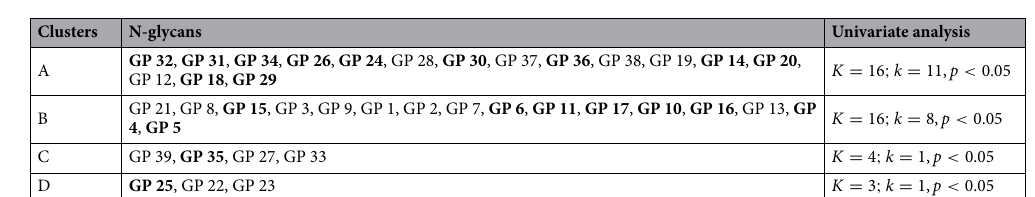
Table 2. Analysis of N-glycans expressive signatures between T2DM cases and healthy controls across the four clusters. NB: Bold text indicates the glycan expression is significantly different between T2DM cases and healthy controls, compared at 5% level of